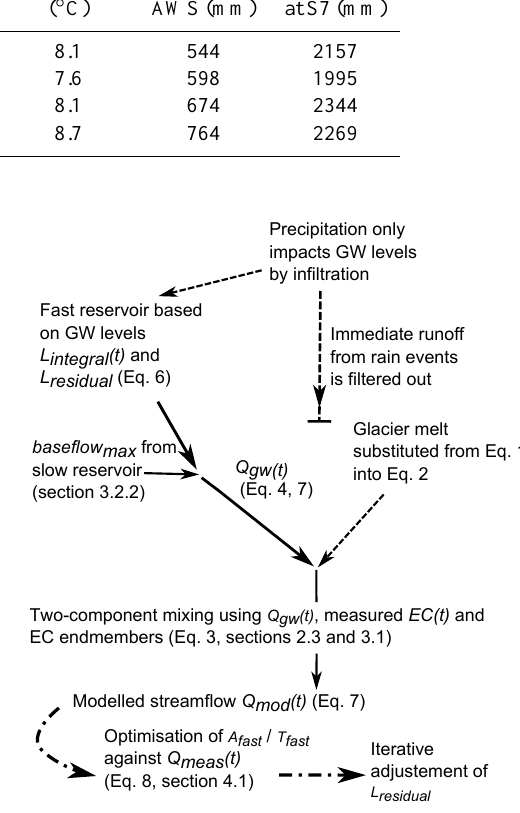
Figure 3. Schematic flow chart summarizing the functioning of the “FULL”